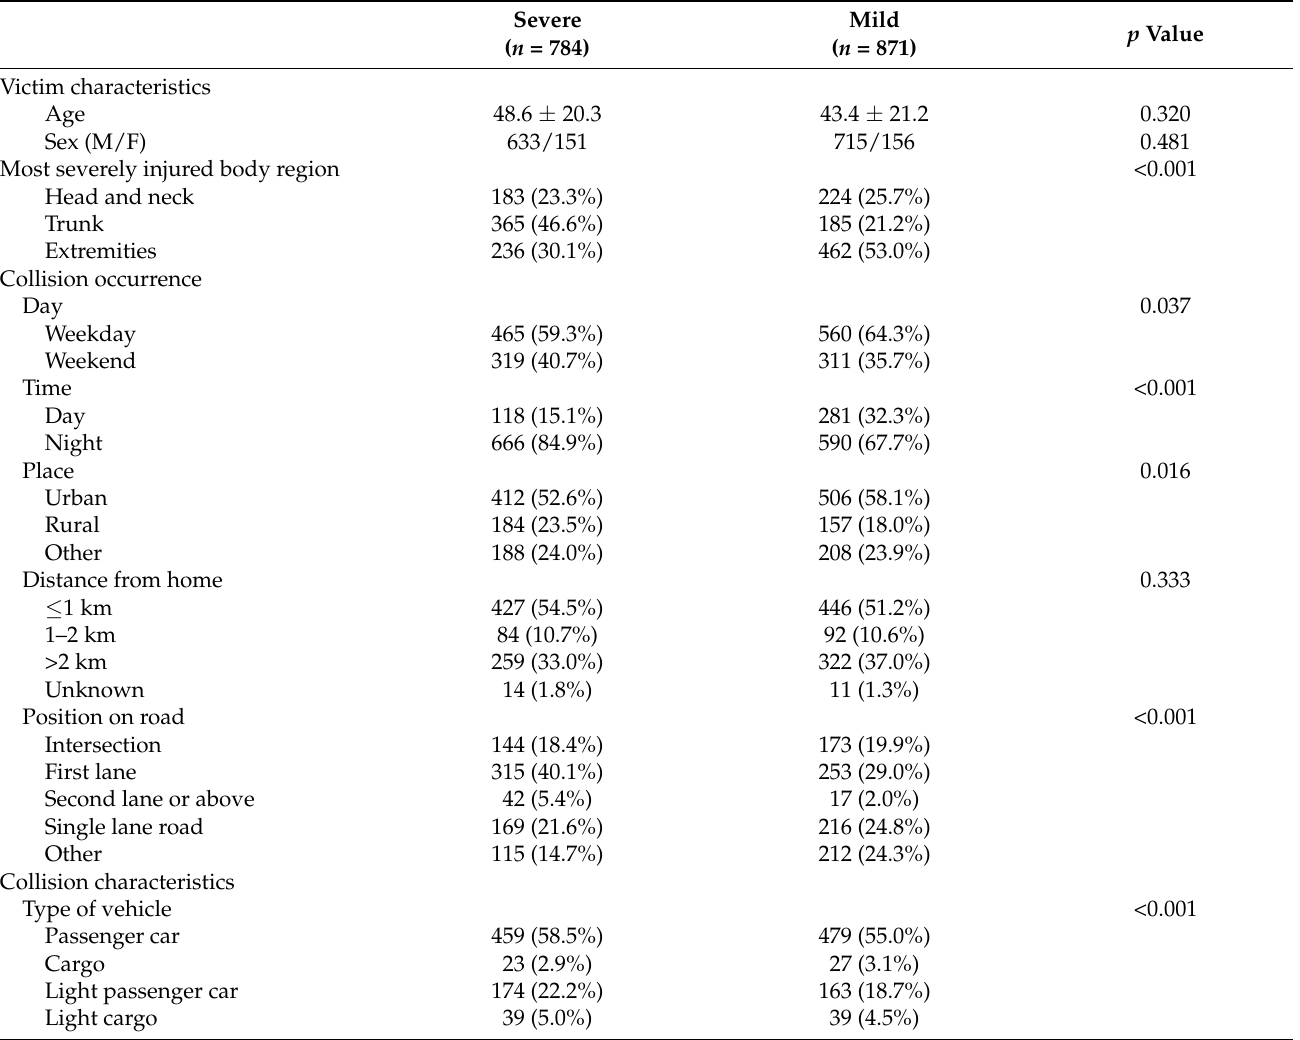
Table 3. Victim and collision characteristics for severe and mild